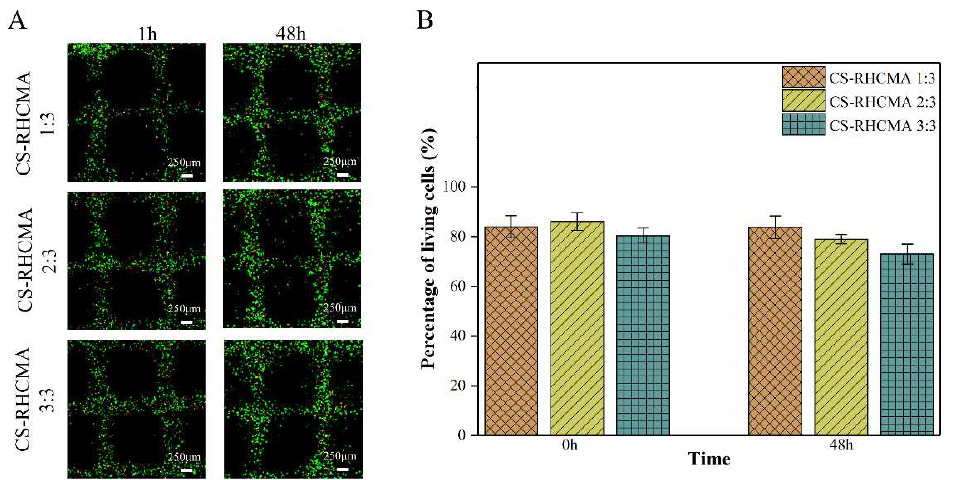
Figure 7. In vitro biocompatibility assessment of printed HUVECs-laden CS-RHCMA bioinks. ( A ) AO/EB double-fluorescent staining of the HUVECs in printed lattices at 1 and 48 h post-printing, respectively. Scale bar = 250 µ m. ( B ) Calculated percentage of living cells within the bioprinted lat- tices.